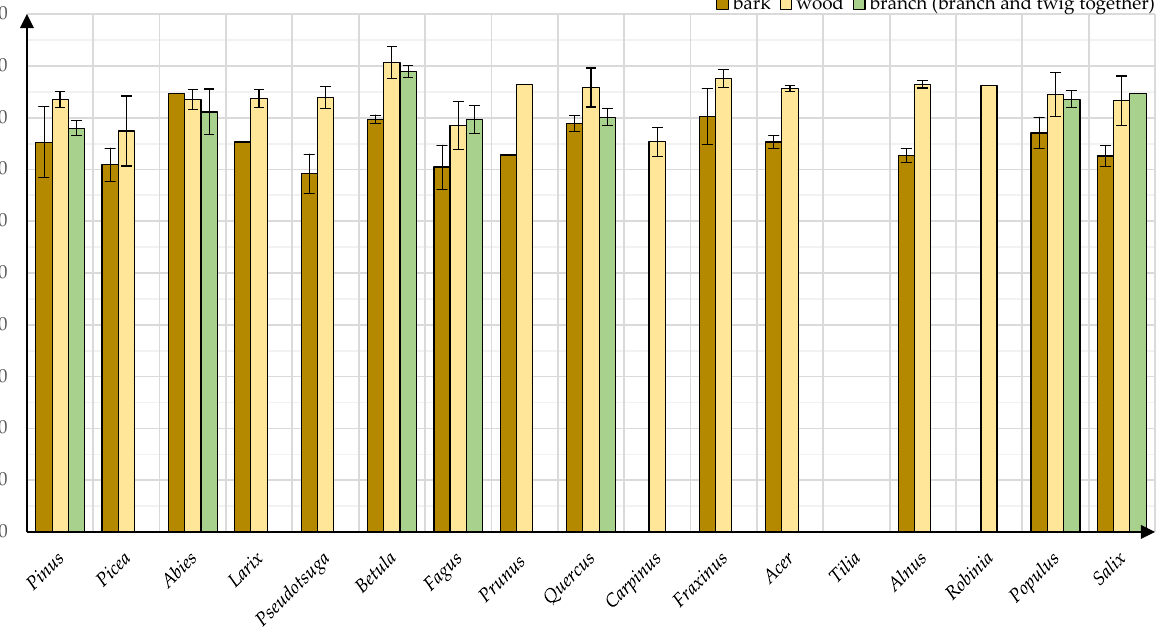
Figure A1. Average value and average deviation of the volatile matter of organs of particular systematic genera trees.